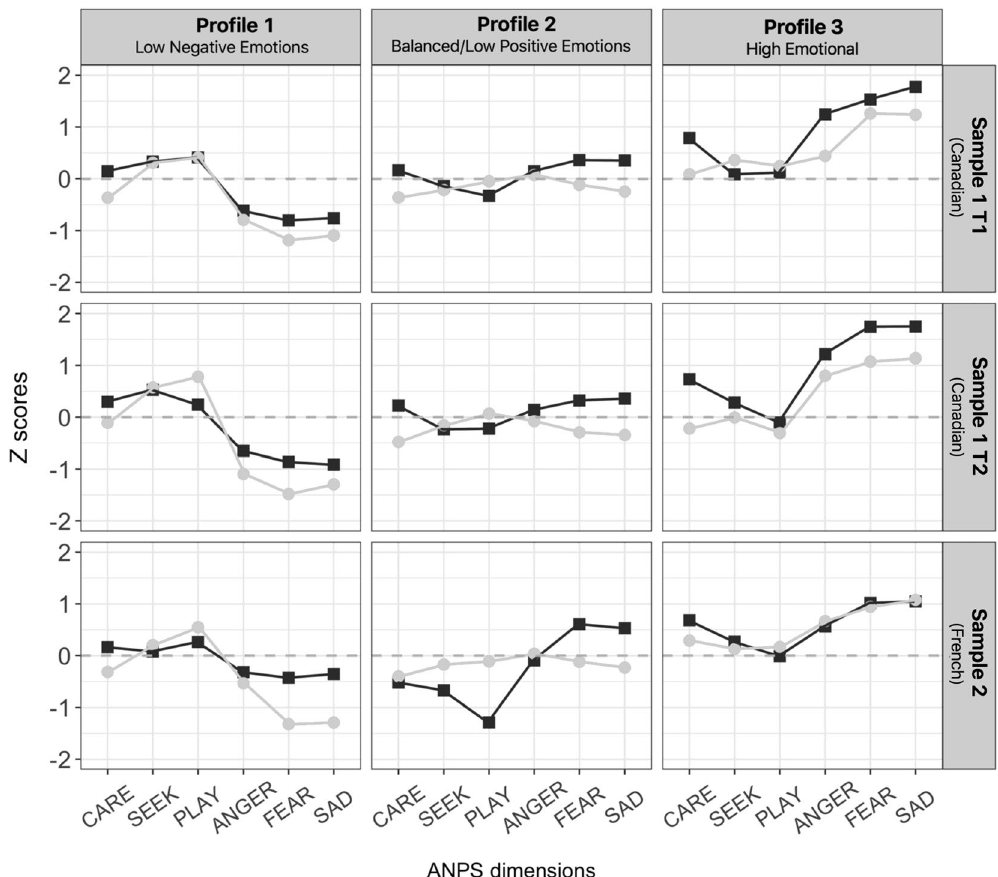
Figure 1. Description of the selected LPA profiles. The figure shows the profile plots for women (black lines) and men (grey lines) by sample. The scores of the 6 dimensions are the standardized estimated means (z